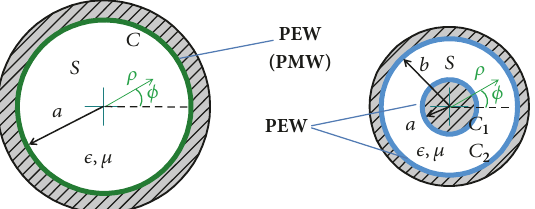
Figure 4: Cross-section of the type of homogenous waveguides used in this work: circular (with PEW and PMW boundary conditions) and circular